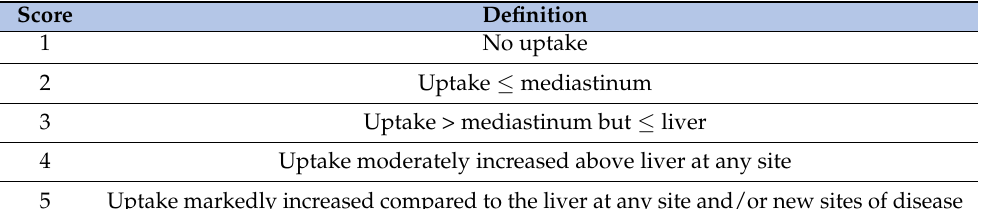
Table 1. Deauville five-point